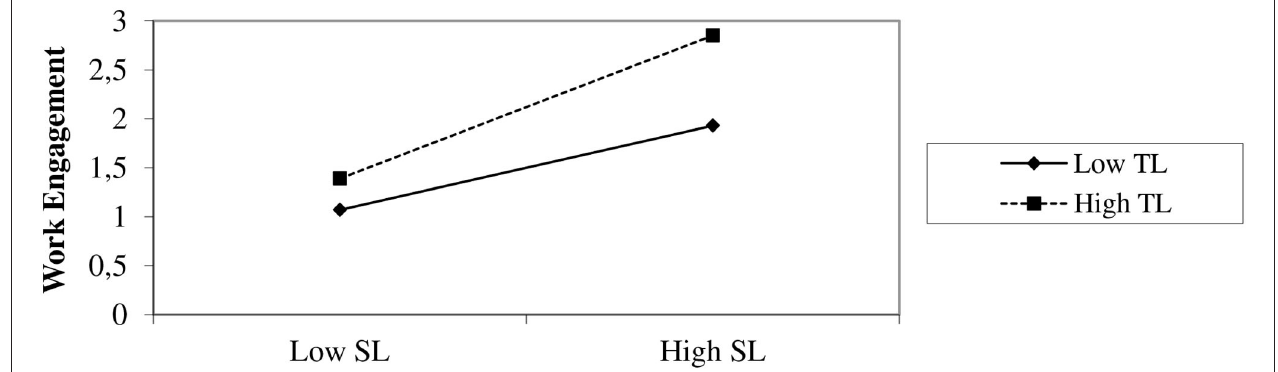
FIGURE 1 | Moderating role of trust in leader between servant leadership and work